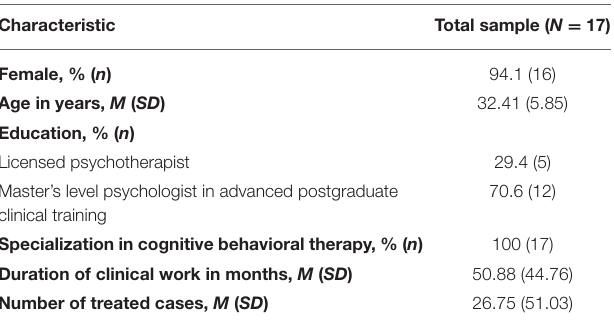
TABLE 4 | Demographic characteristic of study therapists in the feasibility trial of PCT adapted for PGD.